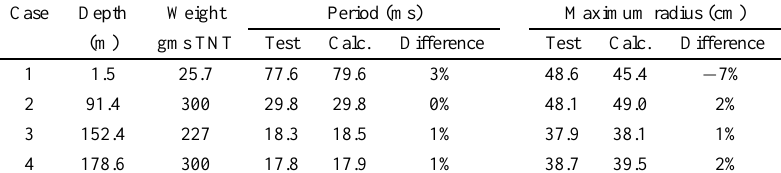
Comparison of uniform Euler predictions and experiment